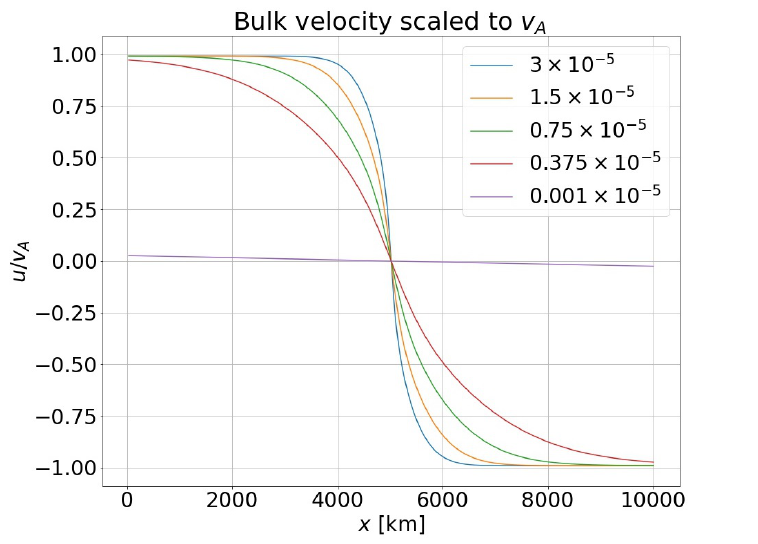
Figure 3. The calculated bulk velocity of energetic particles normalized to the Alfvén velocity in simulations of a coronal loop with the size L = 10,000 km and the spatial cell size ∆ x = 20 km. Different normalization values α are denoted in the